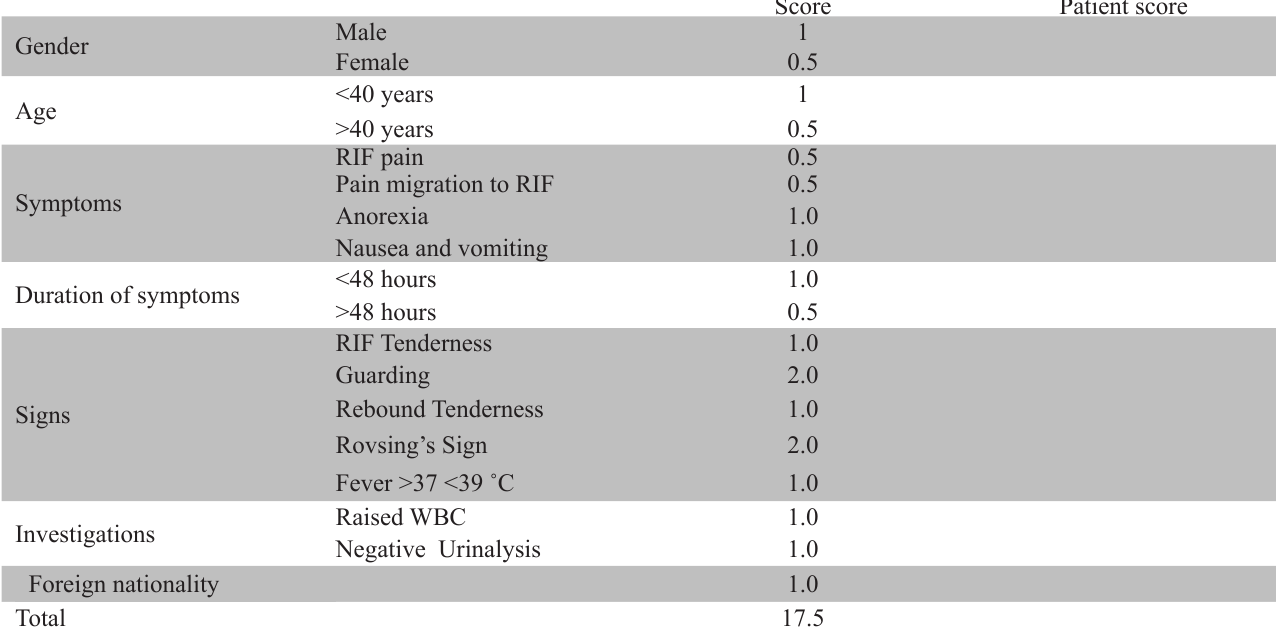
*RIF: Right Iliac Fossa, WBC: White Blood